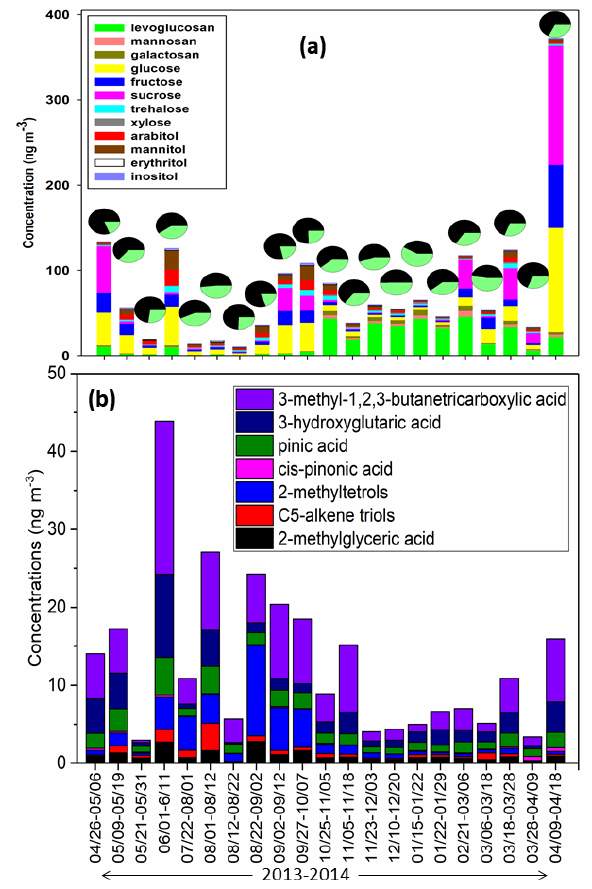
Figure 2. (a) Cumulative concentration levels of anhydrosugars, primary sugars, and sugar alcohols (i.e., represented by bars) and depicting the contributions of nonfossil (green color) and fossil (black color) organic carbon (i.e., pie charts). (b) Cumulative con- centration levels of isoprene and monoterpene SOA tracers in each TSP sample collected over